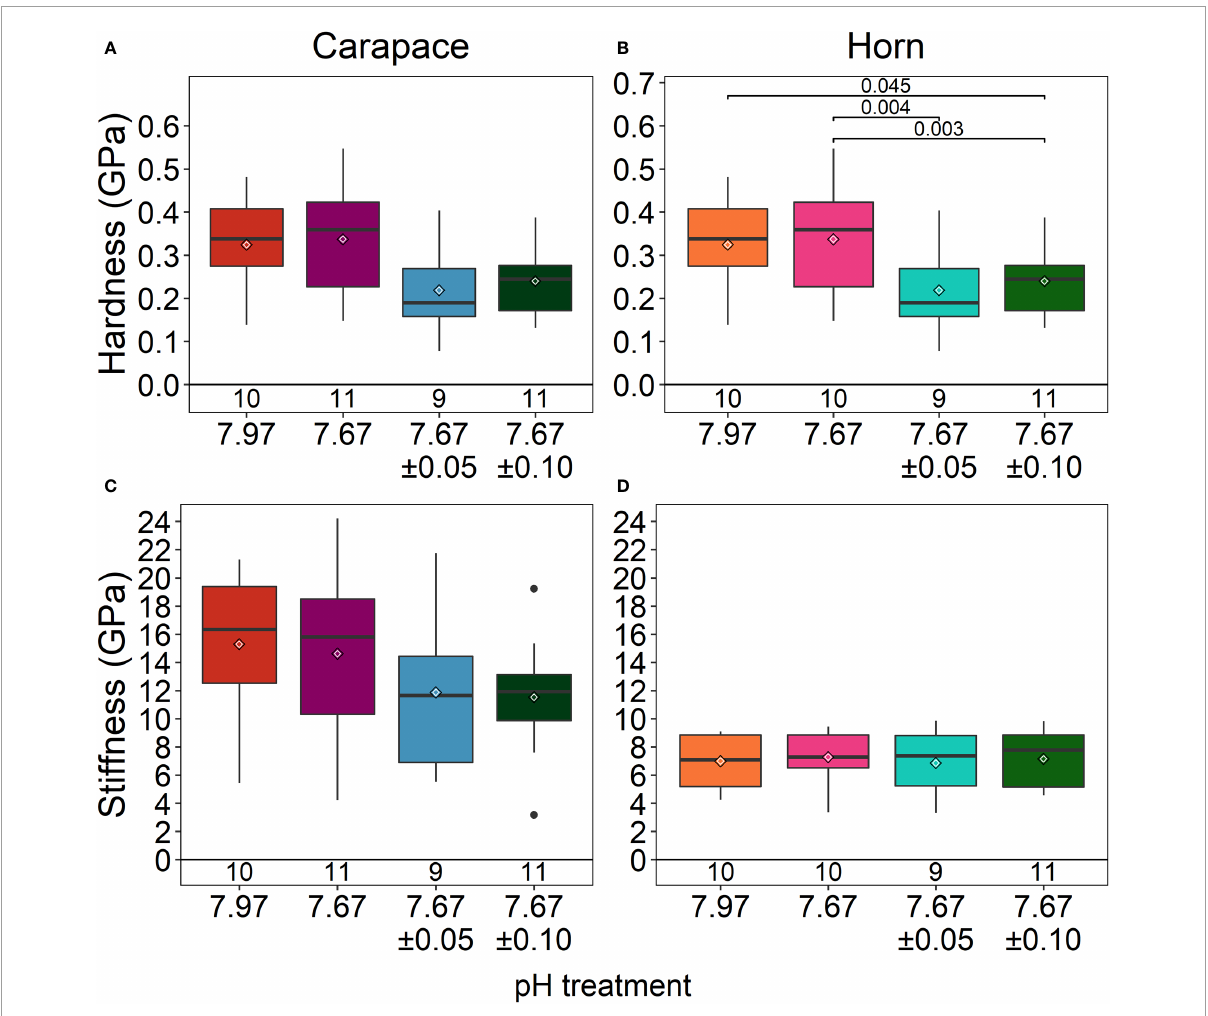
FIGURE 5 Material properties of the carapace spine (A, C) and rostral horn (B, D) . The carapace spine did not show any differences in material properties among treatments. The horn significantly differed in hardness. Lobsters exposed to reduced/high fluctuating pH conditions had horns that were less hard than those exposed to stable pH conditions (both ambient and reduced pH). Box boundaries are the first and third quartiles, whiskers are 1.5 times the interquartile range, the center line is the median, black and white diamonds are the mean, and outliers are solid dots. Values on the bottom of panels denote sample